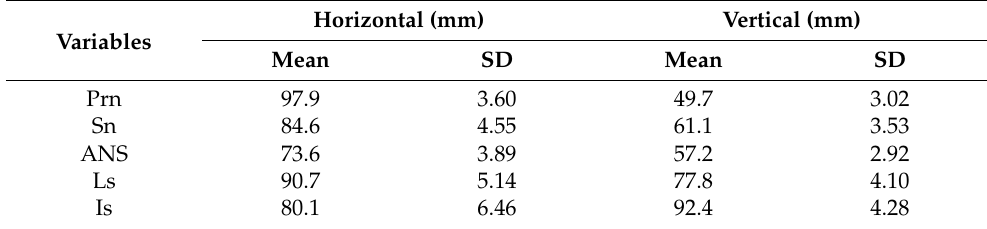
Table 1. Summary of preoperative landmarks ( n =